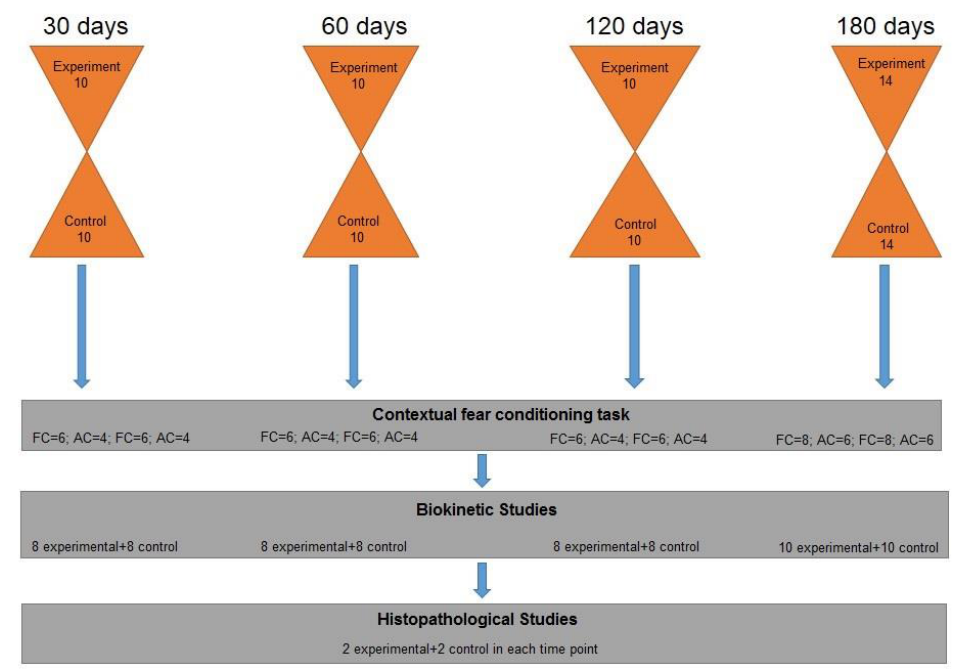
Scheme 1. Schematic diagram of the general route of the experiment with the mammals.